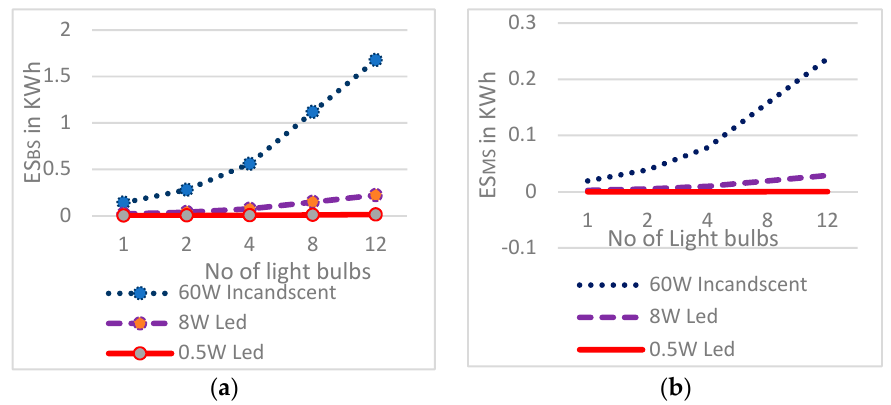
Figure 11. Energy saving ratio vs. number of light bulbs for: ( a ) comparison of ES BS of 60 W incandescent light, 8 W LED and 0.5 W LED light bulbs; ( b ) comparison of ES MS of 60 W incandescent light, 8 W LED and 0.5 W LED light bulbs.